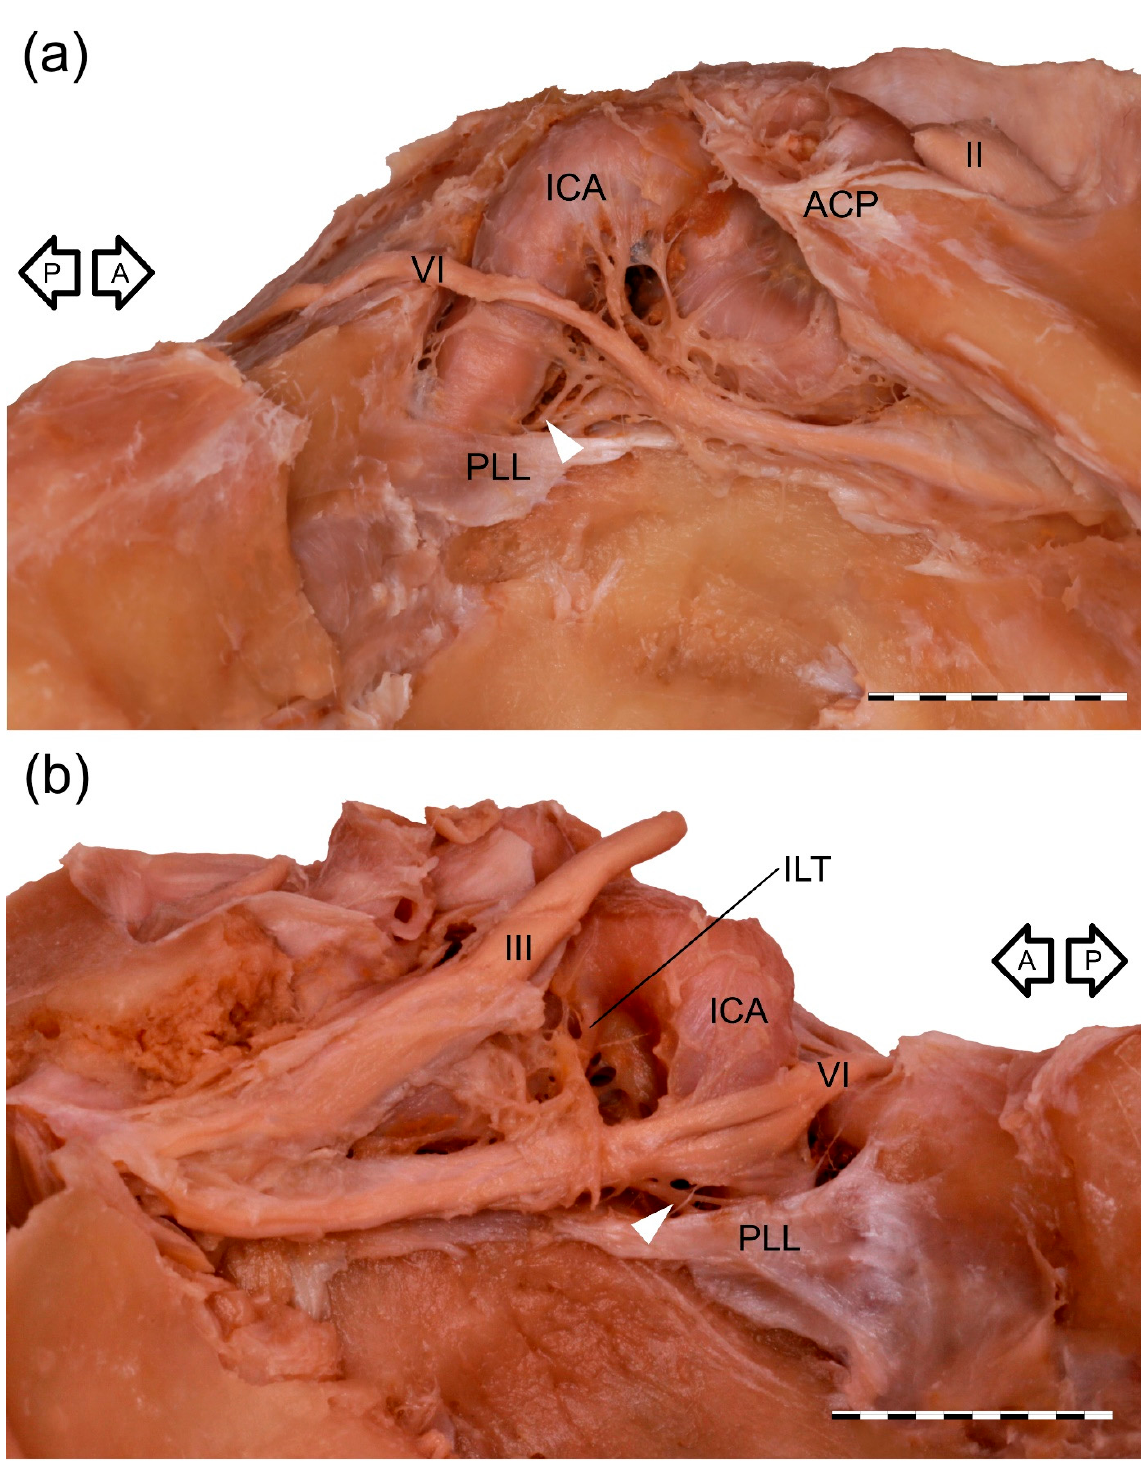
Figure 1. Anatomical variations of the AN cavernous segment. Note the different distances of the AN (VI) to the petrolingual ligament (PLL) superior border. White arrowhead marks an anterior bundle of the sympathetic nerve fibers joining the AN’s inferior aspect. ( a ) Wet anatomical specimen of the right CS. A single AN (VI) running within the CS. ACP—anterior clinoid process; II—optic nerve; III—oculomotor nerve. ( b ) Wet anatomical specimen of the left CS. Division of the AN (VI) into separate rootlets at the point of contact with the cavernous carotid artery’s vertical segment. III—oculomotor nerve; ILT—inferolateral trunk. Black arrows indicate anterior (A) and posterior (P) directions. Scale bar corresponds to 10 mm.